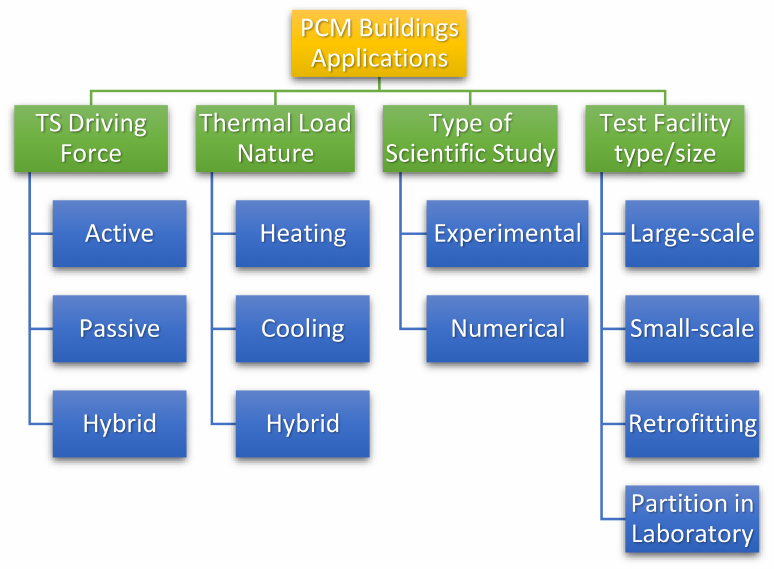
Figure 1. Classification criteria for PCM building